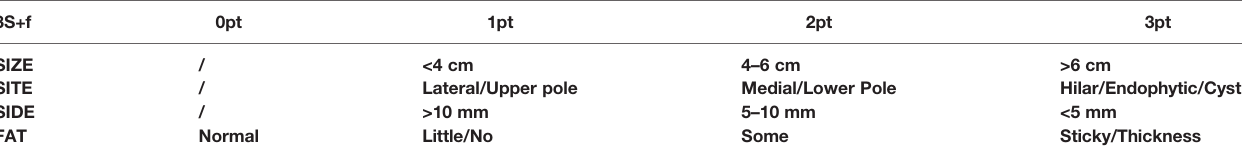
TABLE 1 | “ 3S+f ” nephrometry score system.